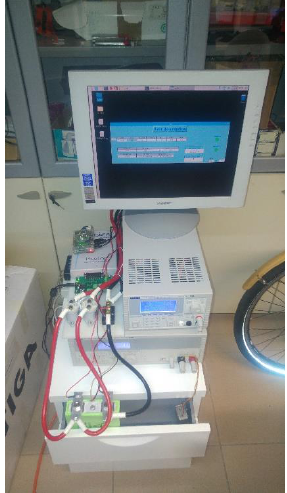
Figure 8. Cell Station Tester experimental setup.